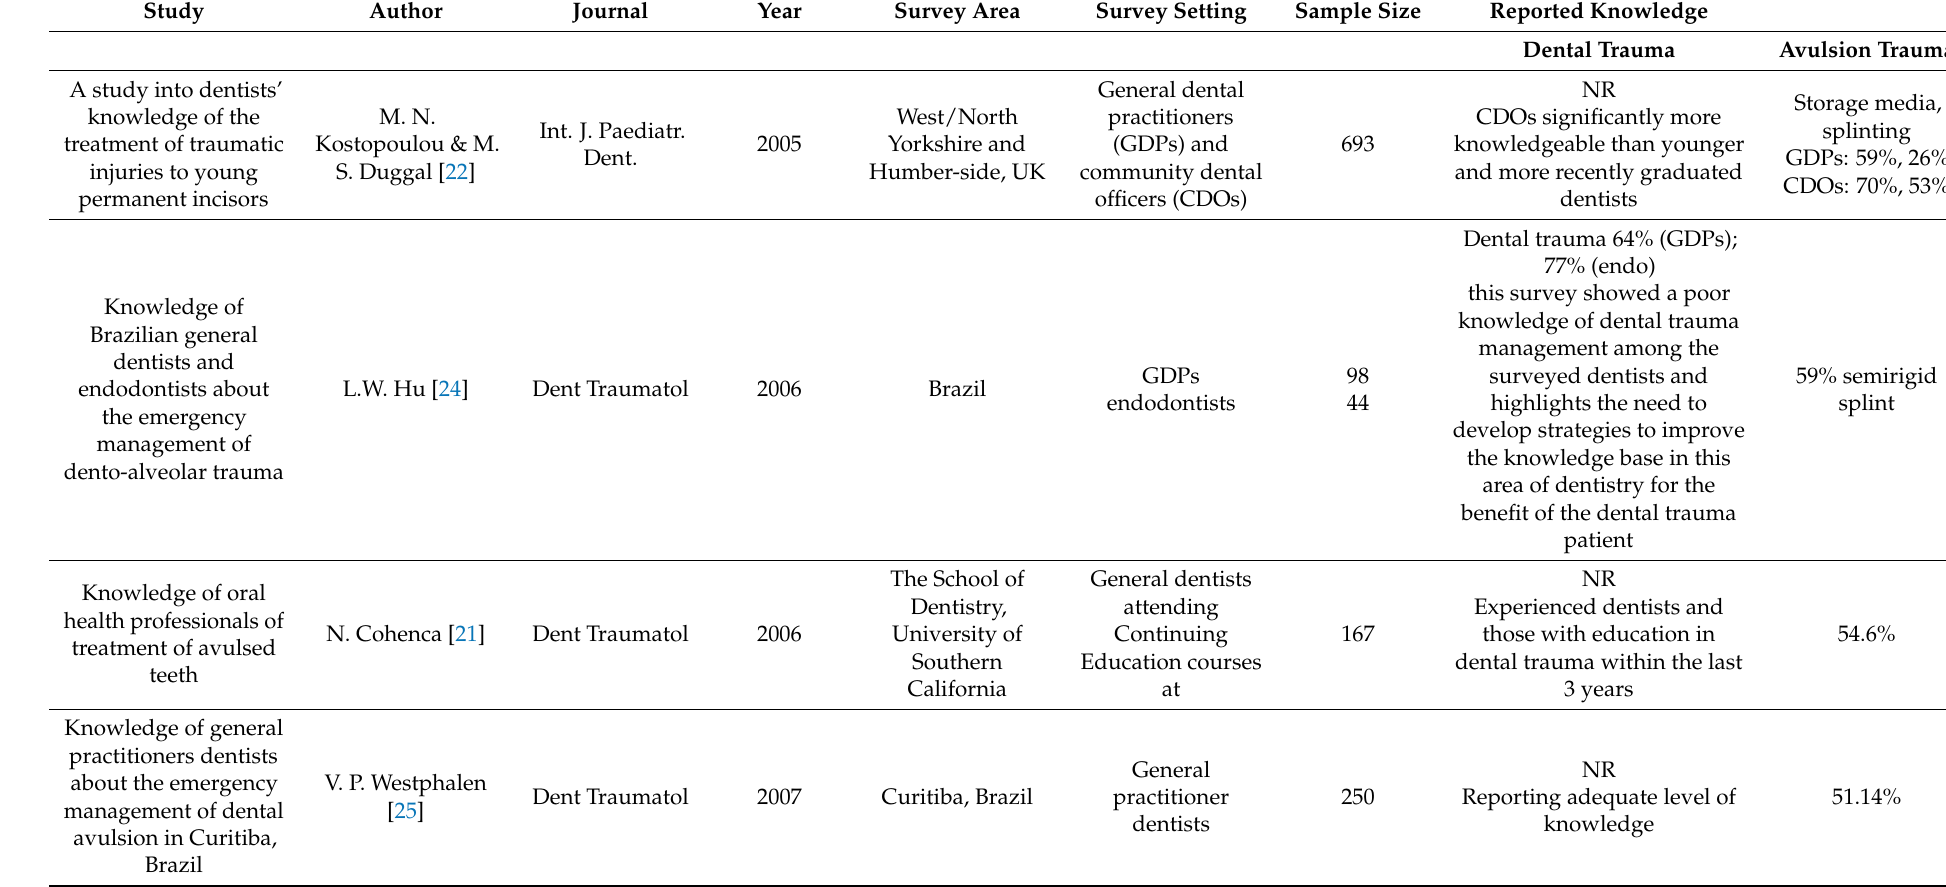
Table 5. Summary of studies included in the